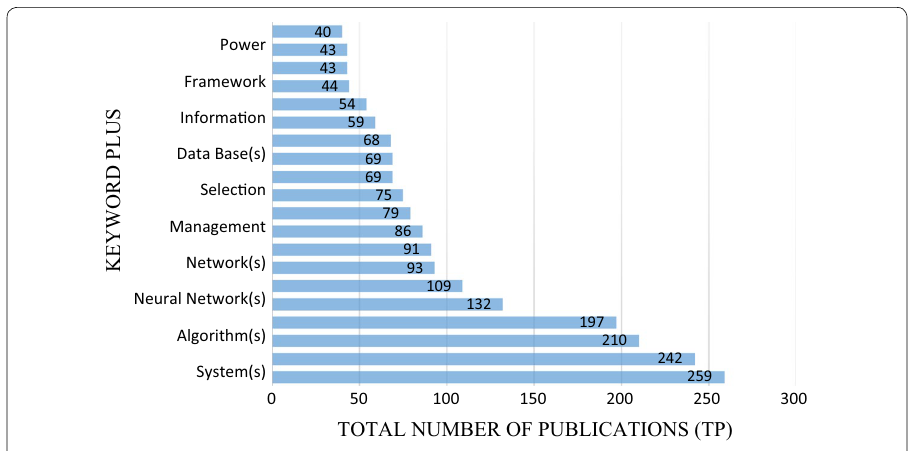
Fig. 5 Top 10 most frequently used terms of KeyWords plus (from 1980 to 2015)